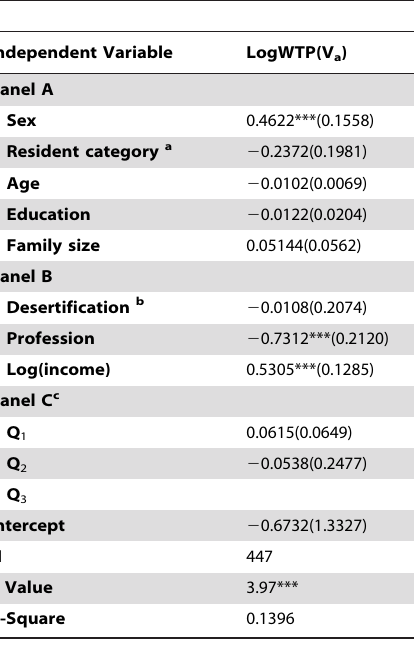
Table 2. Regressions of V a , V b and V d .